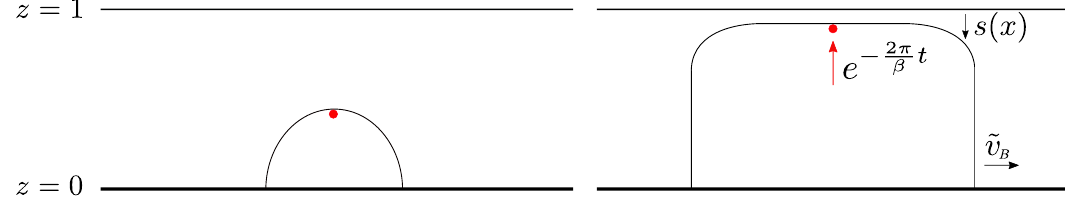
Figure 4 . An illustration of the entanglement wedge method. A particle is released from the asymptotic boundary and we show the RT surface which barely encloses the particle. At early times (left), the profile of the RT surface depends sensitively on the metric away from the horizon; but at late times (right), the RT surface in the near-horizon region has a characteristic profile which propagates outwards at the butterfly velocity v B e